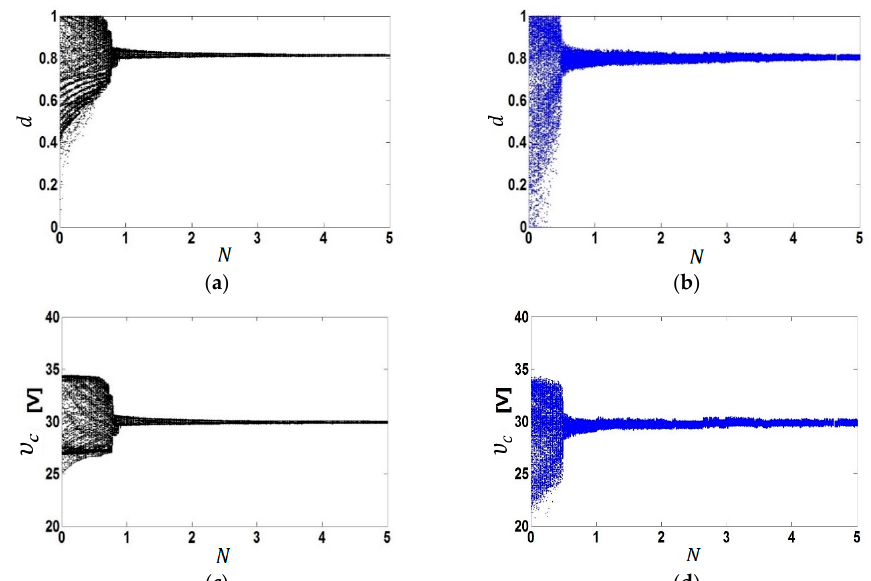
Figure 13. Bifurcation diagrams for the simulation and experimental test of the system with ZAD ( K S 3 = 35) and FPIC, changing the parameter N and maintaining fixed values of K S 1 = K S 2 = 2: ( a ) d vs. N for the simulation test; ( b ) d vs. N for the experimental test; ( c ) υ c vs. N for the simulation test; and ( d ) υ c vs. N for the experimental test.